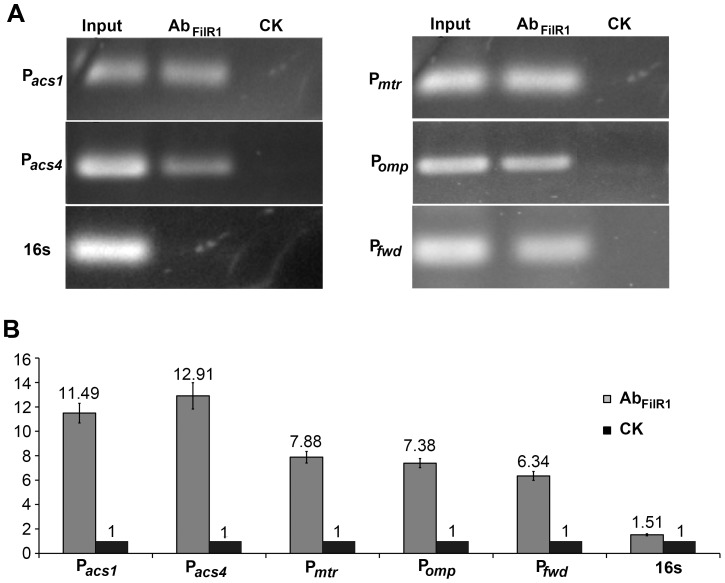
ChIP-PCR and ChIP-qPCR detected FilR1 associations with the promoters of genes for methanogenesis inside M. harundinacea cells.(A) PCR products amplified with the indicated primers using anti-FilR1 antibody immunoprecipitated DNA (AbFilR1) as a template and mock-IP DNA as a negative control (CK). (B) qPCR assays detected the enrichment of DNA fragments in anti-FilR1 antibody immunoprecipitated samples (AbFilR1, gray bar) over mock-IP negative control samples (CK, black bar). Pacs1, promoter region of operon acs1; Pacs4, promoter region of acs4; Pmtr, promoter region of operon mtr; Pfwd, promoter region of the operon fwdCABD; Pomp, promoter region of omp and 16s, intragenic DNA fragment of 16S rDNA used as the control.